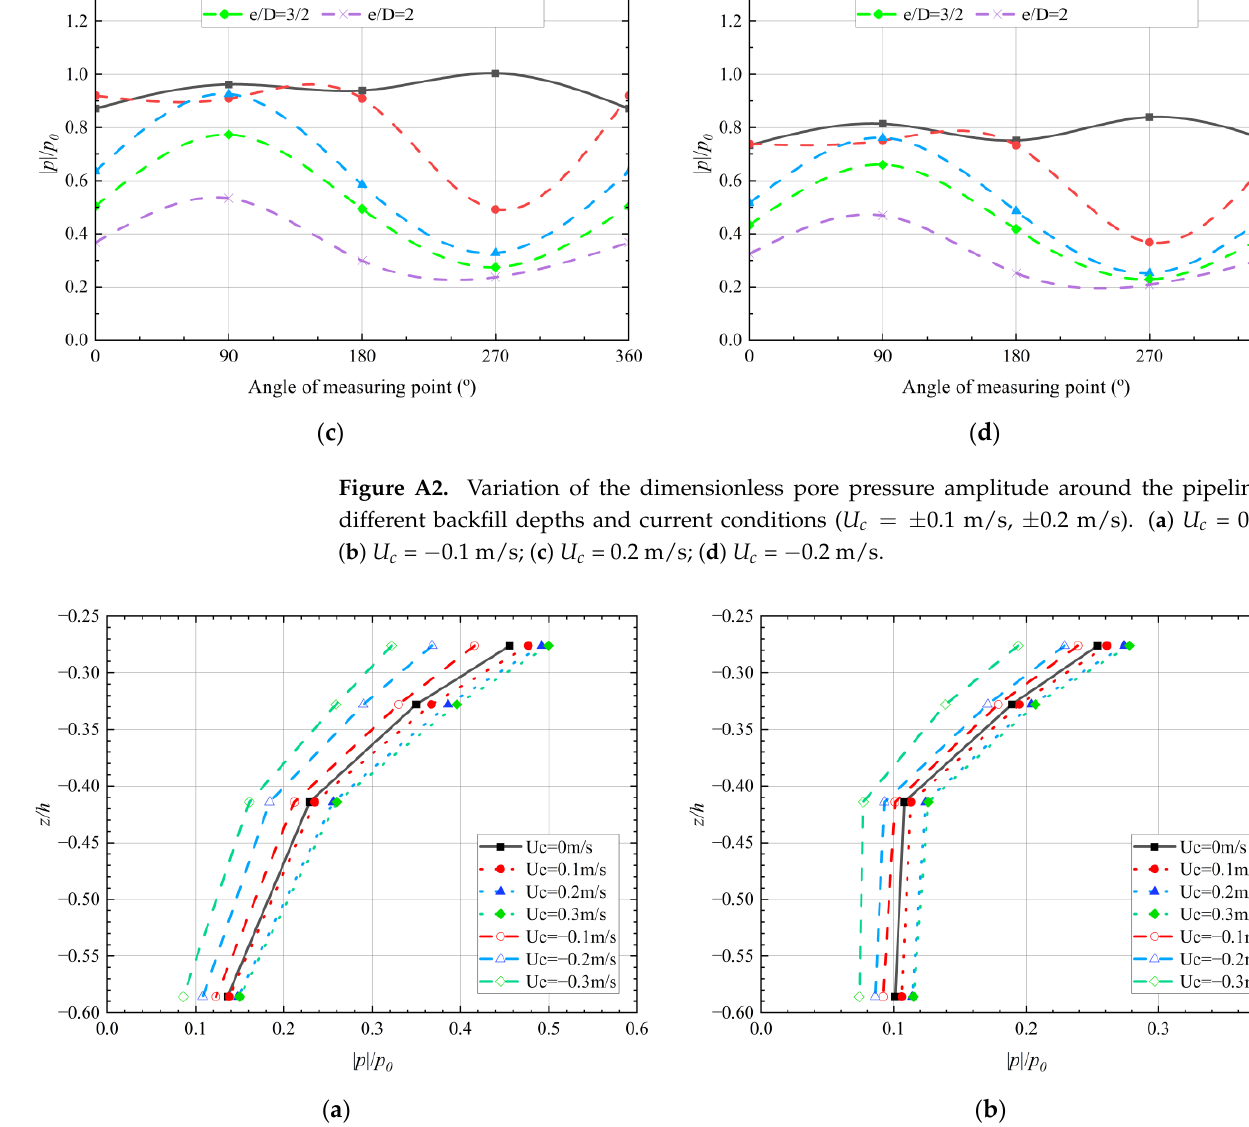
Figure A3. Variation of the dimensionless pore pressure amplitude beneath the pipeline with different backfill depths (e/D = 1/2, 3/2) and current conditions. ( a ) e/D = 1/2; ( b ) e/D = 3/2.